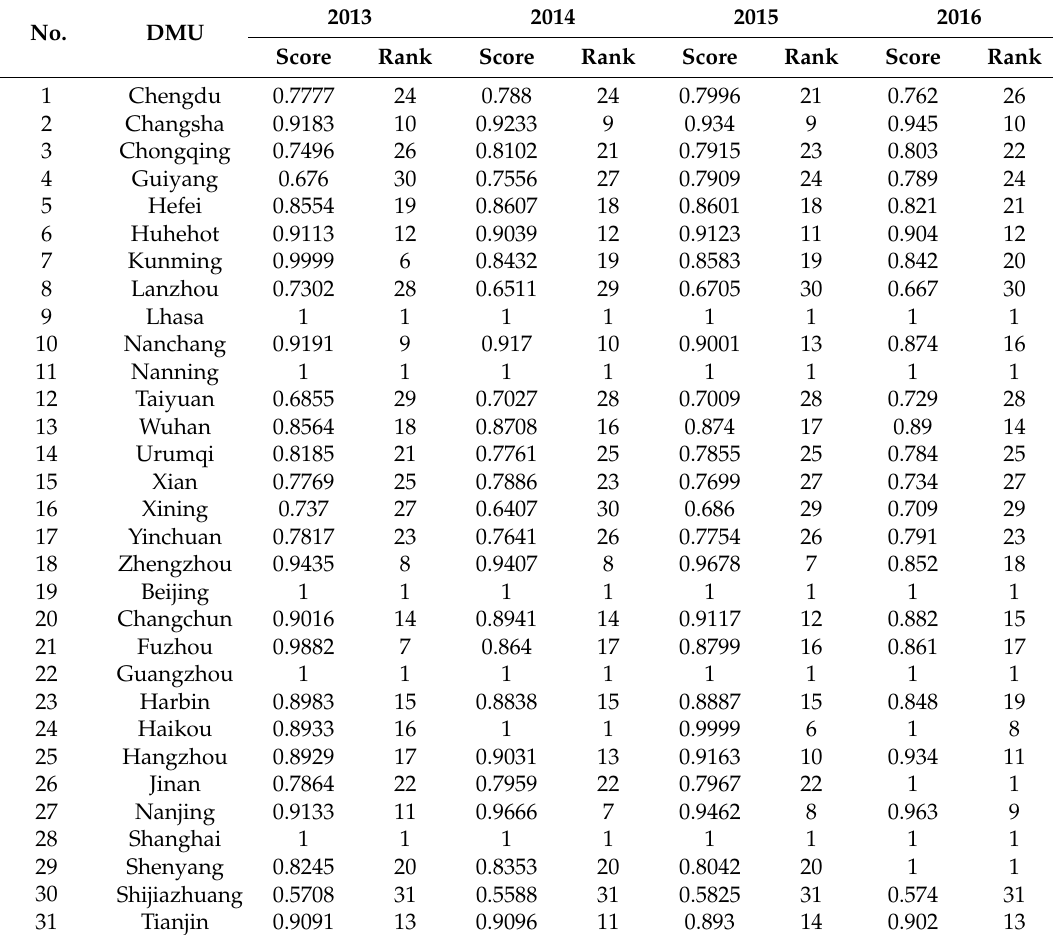
Table 1. Overall efficiency score rankings between 2013 and 2016.